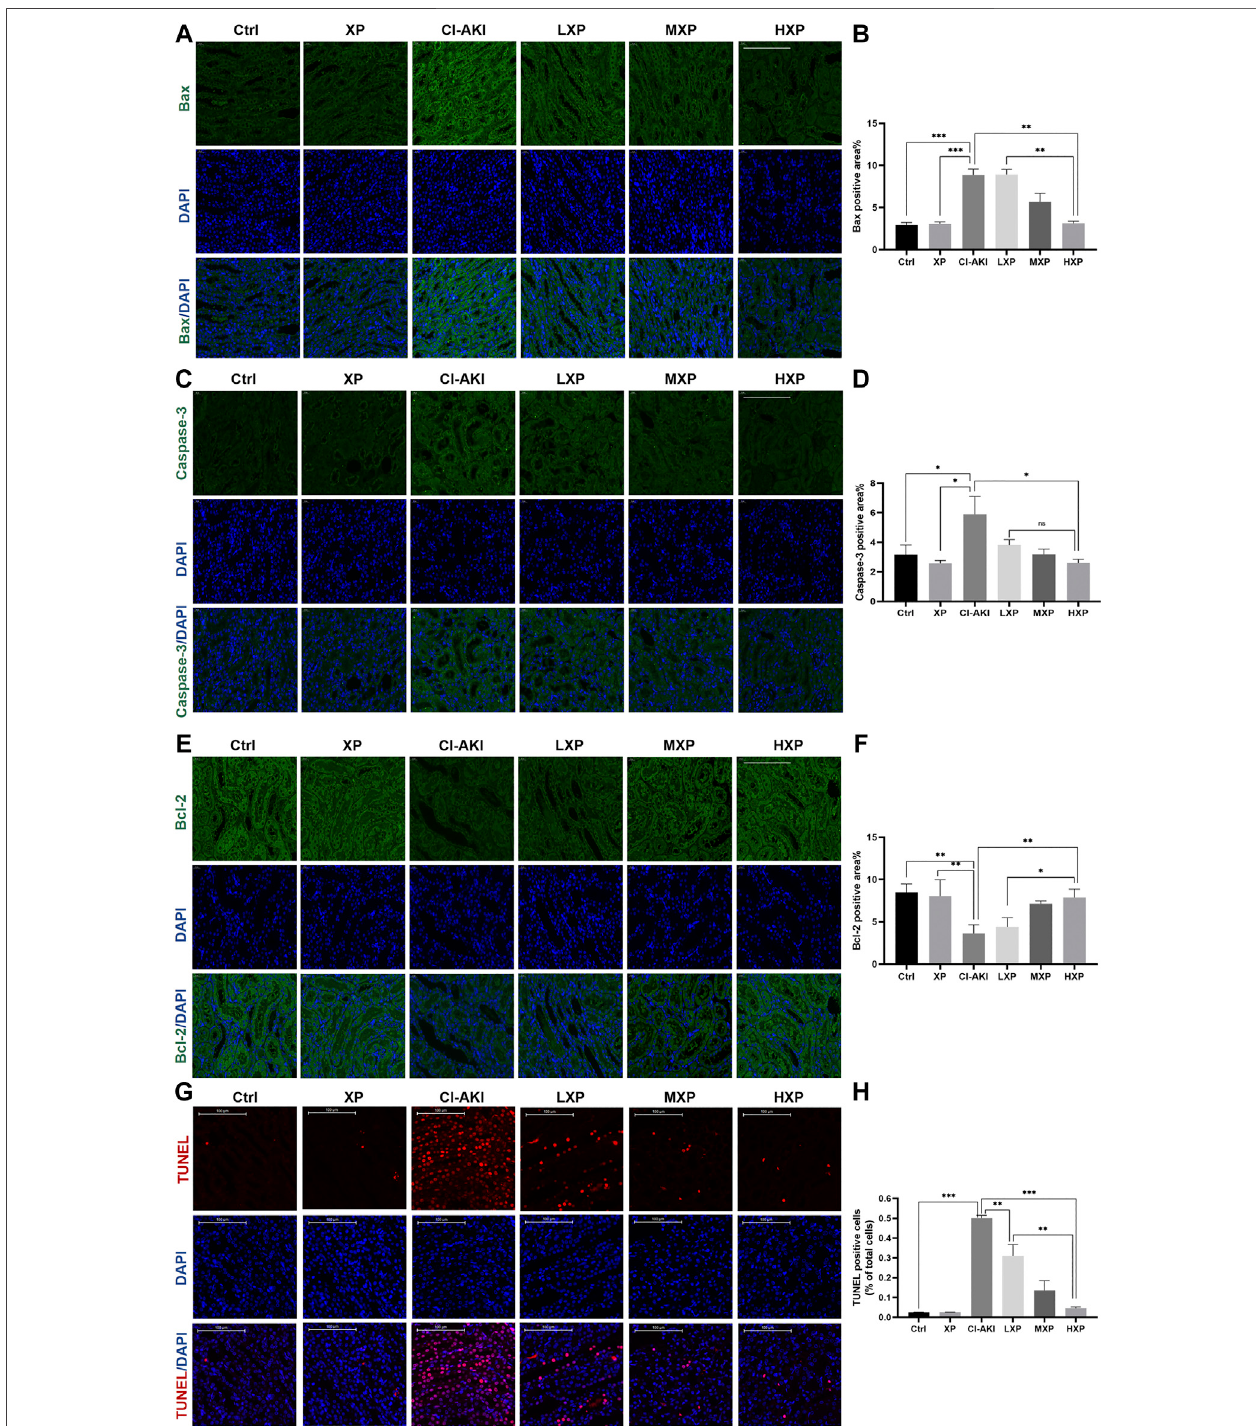
FIGURE 4 | The anti-apoptotic effects of XP in CI-AKI . (A) Bax (green) signals (Magni fi cation: × 400, scale bar: 100 μ m) and (C) caspase-3 (green) signals (Magni fi cation: × 400, scale bar: 100 μ m) were immuno fl uorescent analyzed. The results indicated that iohexol induced obvious apoptosis in the kidney. Decreased signals on bax and caspase-3 were detected when XP was given to iohexol-injured rats. (B and D) The semi-quantitive analysis showed the bax, caspase-3 positive percentageineachgroup. (E) Bcl-2(green)signals(Magni fi cation: × 400,scalebar:100 μ m)increaseddose-dependentlyintreatmentgroupswhereasthesignalin theCI-AKIgroupwasweak,whichdemonstratedthatXPcanmitigateiohexol-inducedapoptosis. (F) Columnsshowedthebcl-2positivepercentage ineachgroup. (G) TdT-mediated dUTP nick end labeling (TUNEL) staining (red) of kidney sections (Magni fi cation: × 400, scale bar: 100 μ m). Iohexol exposure induced signi fi cantly